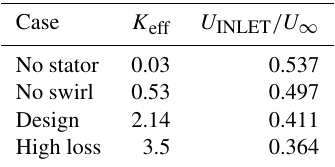
Table 2. Relationship between inlet velocity ratio and interior